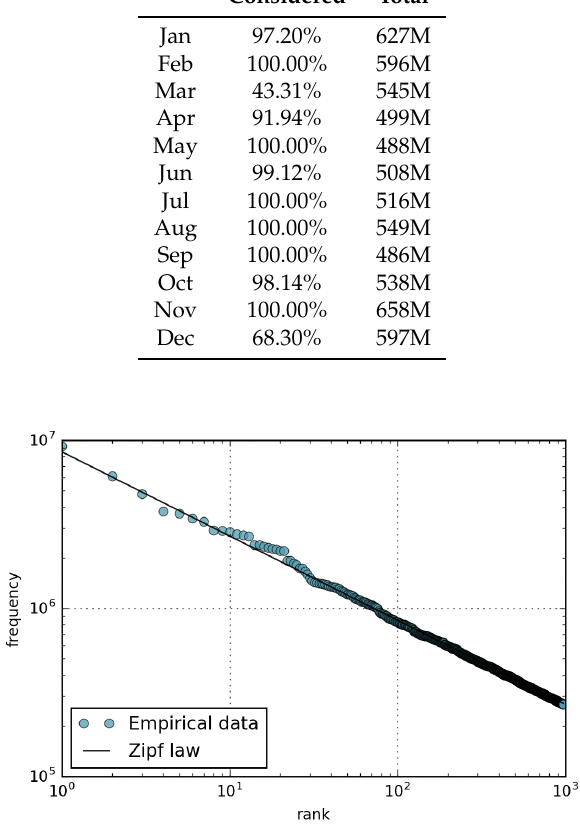
Figure 3. Rank-frequency distribution for views of the 1000 most popular Wikipedia pages in July 2016.